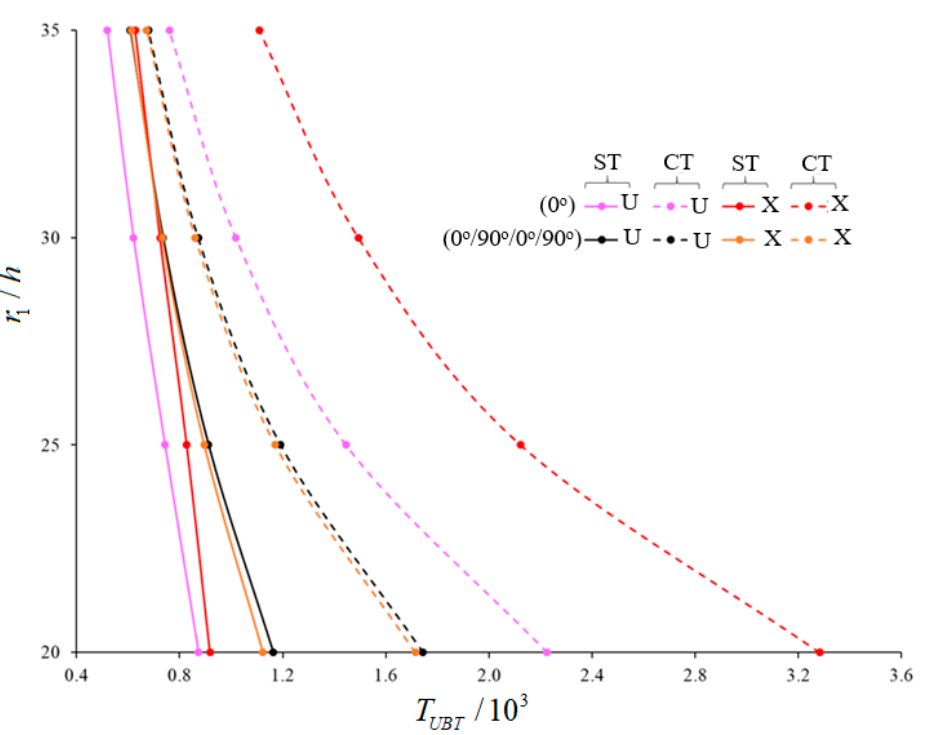
Figure 6. Variations of UBT for (0 ◦ )-single-layer and (0 ◦ /90 ◦ /0 ◦ /90 ◦ )-array laminated cones with U- and X -shaped layers for Cos-Hyp-TSS function (within CT versus r 1 / h ).